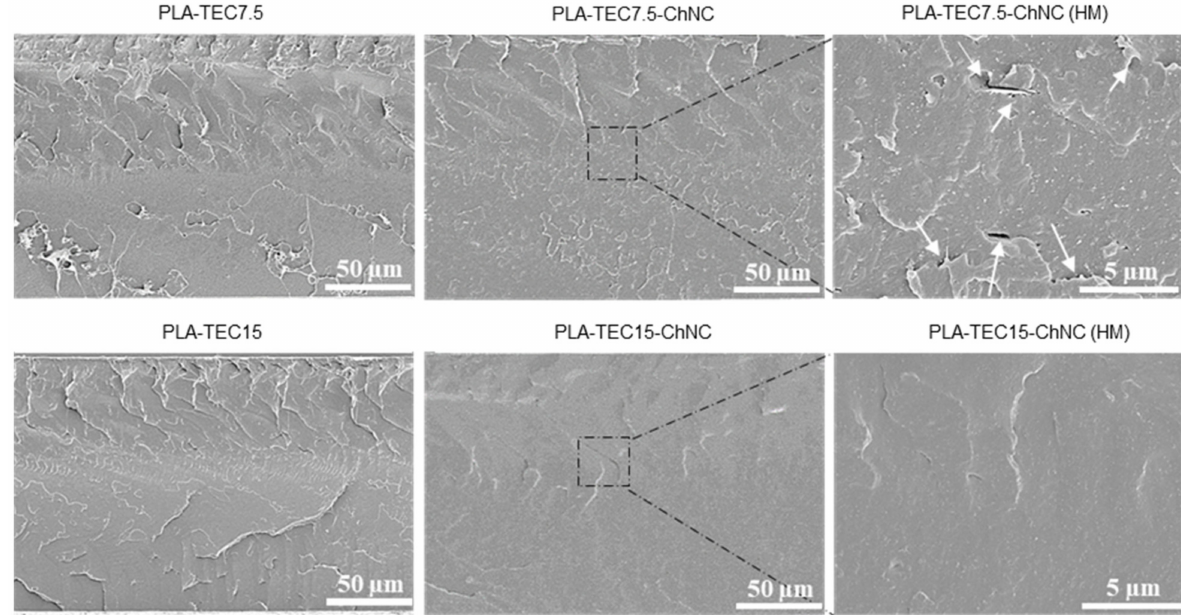
Figure 4. High-resolution SEM images of the cryofractured surface of the material prepared with 7.5 and 15 wt% TEC display that the pore formation due to the presence of agglomerates in PLA-TEC7.5-ChNC, while PLA-TEC15-ChNC possesses a smooth surface due to a better dispersion of ChNCs (HM: higher